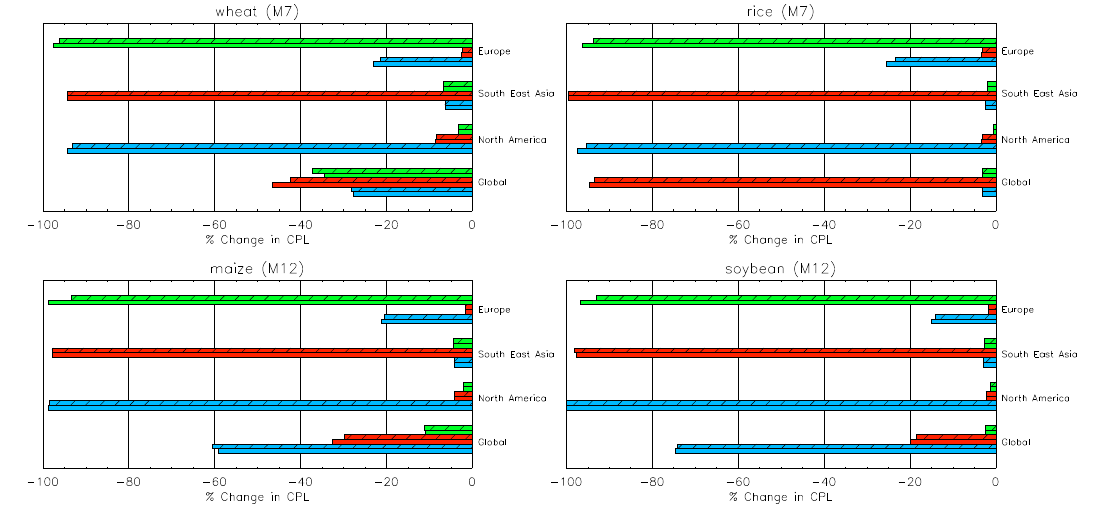
Fig. 11. As Figure 10, but using the M7 and M12 metrics for 4 of the